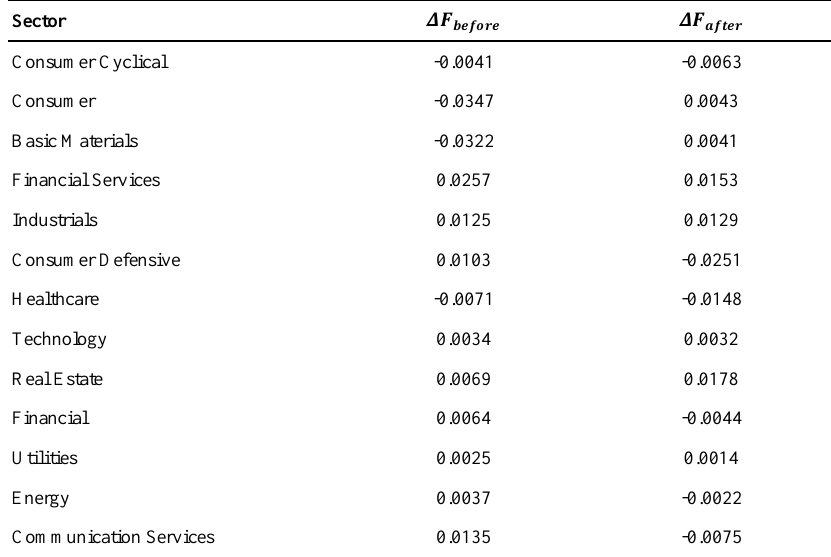
Table 10. The net information outflow for the sectors in SASE market, before and after COVID-19